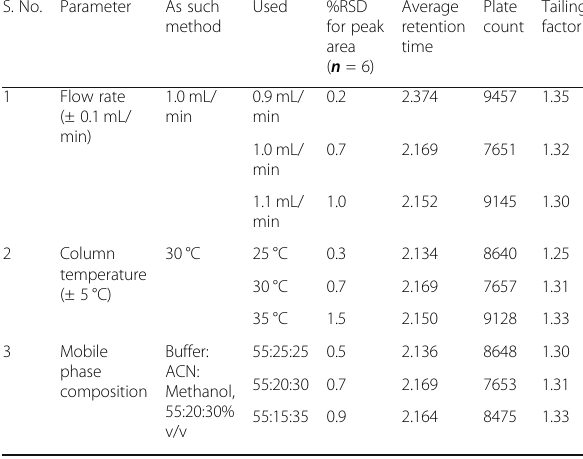
Table 8 Robustness Results for